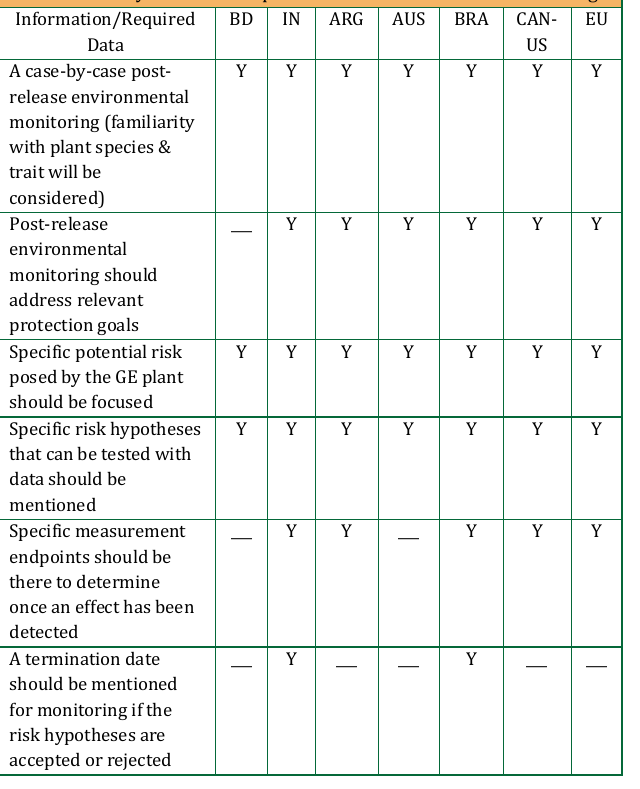
Table 8: Analysis of data on post-release environmental monitoring Information/Required